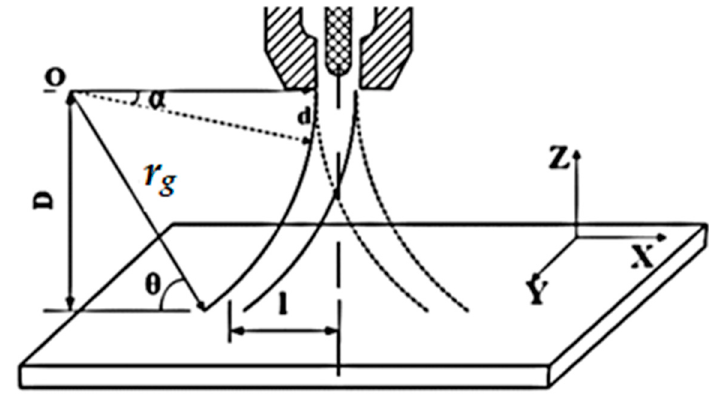
Figure 3. The magnetic field is about the Y-axis, the Lorentz force about the X-axis, r g is the radius of gyration (i.e., movement of the arc plasma) [17].